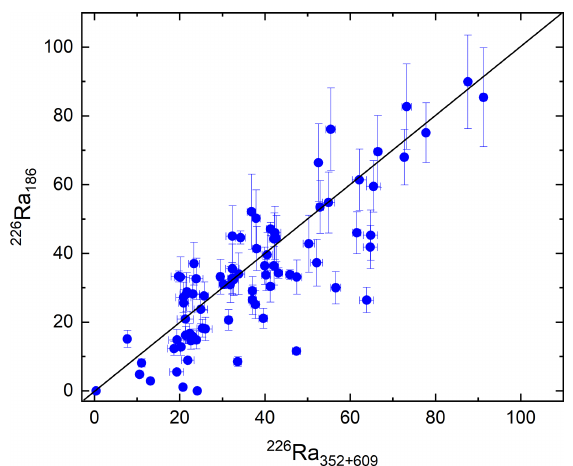
Figure D1. Comparing activity data (Bqkg − 1 ) obtained from the photopeak at 186keV. Each blue dot represents a sample in relation to the 1 : 1 black line. 226 Ra 186 activity is derived from Eq. (C1) corrected for the activity of 235 U directly inferred from its peak at 144keV and plotted versus the weighted mean of activities derived from the 226 Ra daughters emitting 352 and